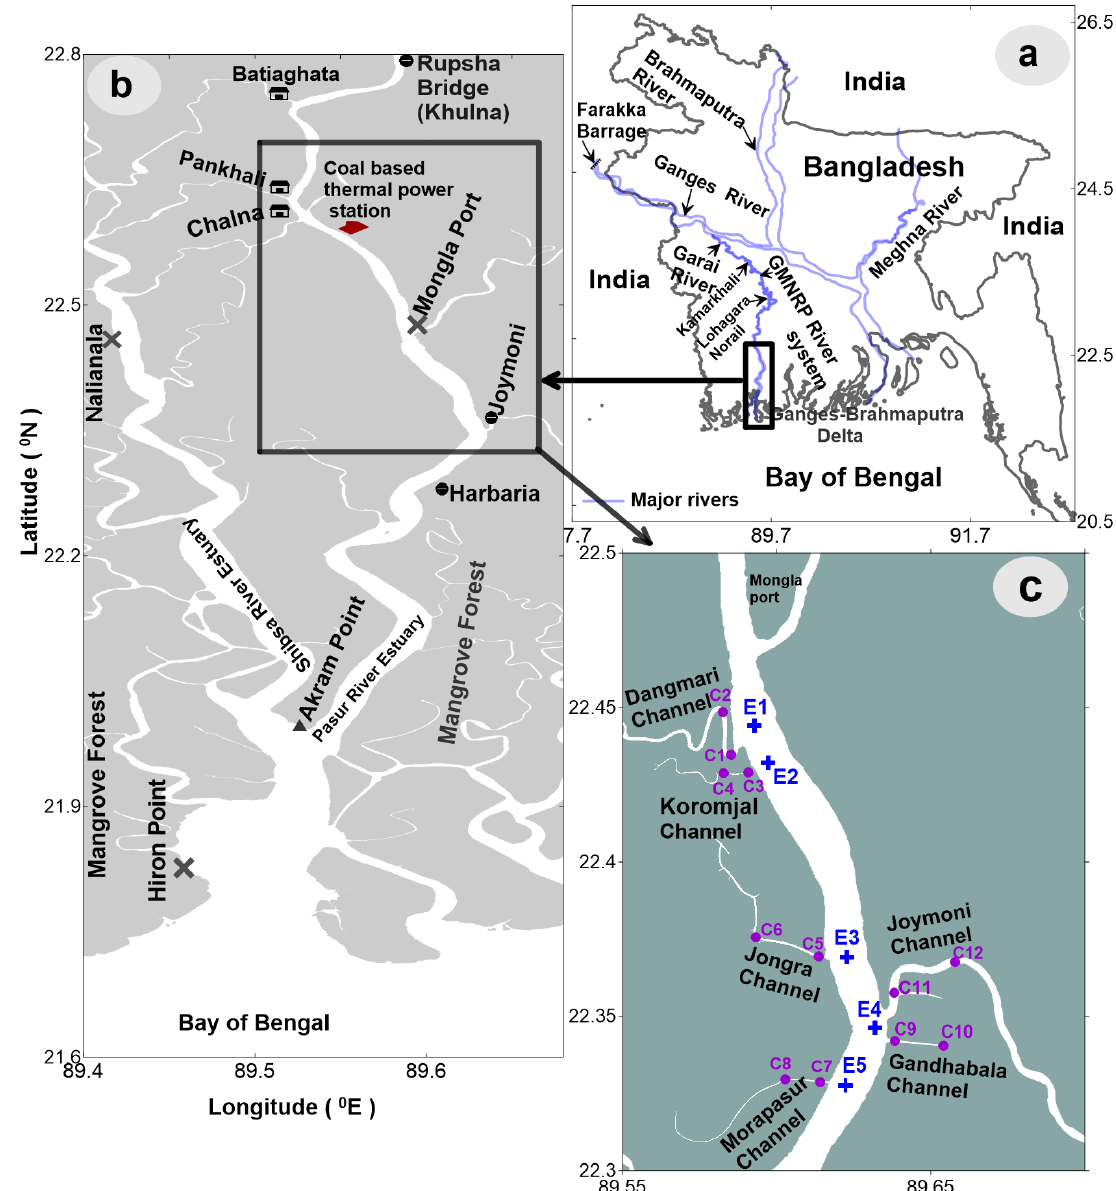
Figure 1. Study area and sampling locations [Mangrove creeks (purple dots): C1, C2; C3, C4; C5, C6; C7, C8; C9, C10 and C11, C12; Pasur River estuary (blue cross): E1, E2, E3, E4 and E5]. ( a ) Bangladesh map, ( b ) Pasur River estuary, ( c ) Sampling sites.